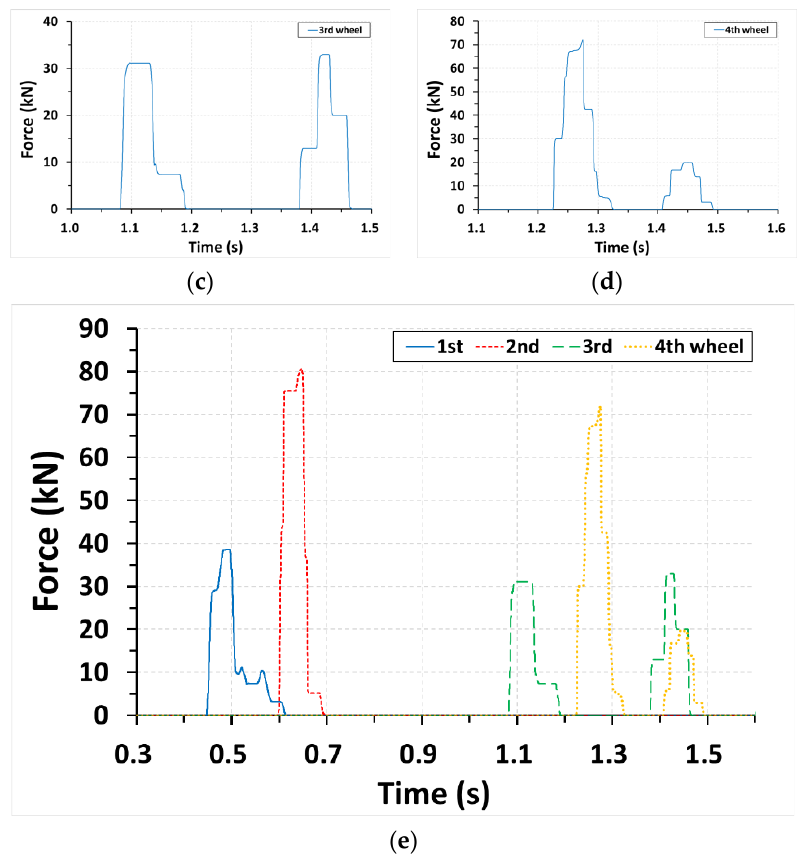
Figure 13. Lateral contact force for each wheel by simulation: ( a ) 1st wheel, ( b ) 2nd wheel, ( c ) 3rd wheel, ( d ) 4th wheel, and ( e ) all wheels.